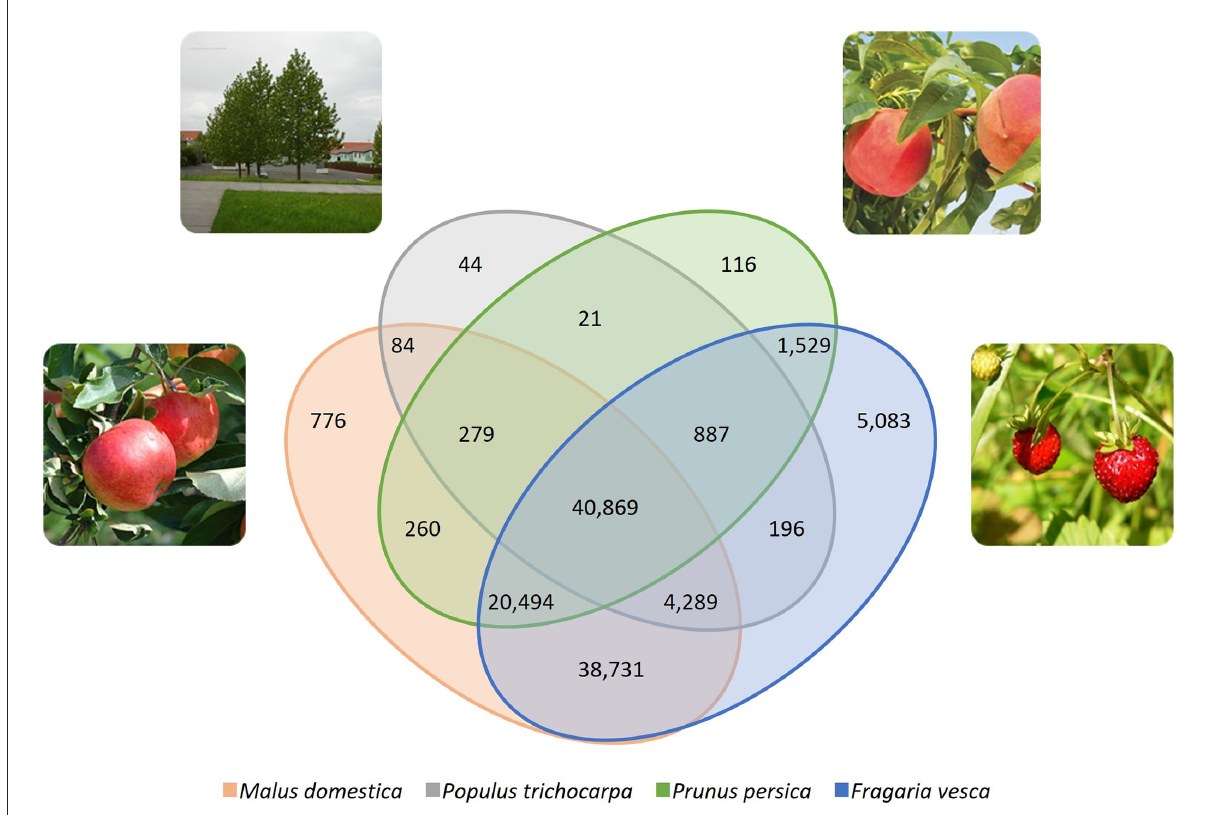
FIGURE2 Venn diagram describing the representation of annotated genes within the different reference genomes. Assembled contigs were subjected to BLASTx analysis against three Rosaceae reference genomes (apple, Malus domestica ; peach, Prunus persica ; strawberry, Fragaria vesca ) and that of poplar ( Populus trichocarpa ). A total of 98,710 (48%) Fragaria chiloensis transcripts were matched against the reference genomes using a cutoff e value of 1e − 5 . Reference genomes were obtained from Phytozome v. 10 betas